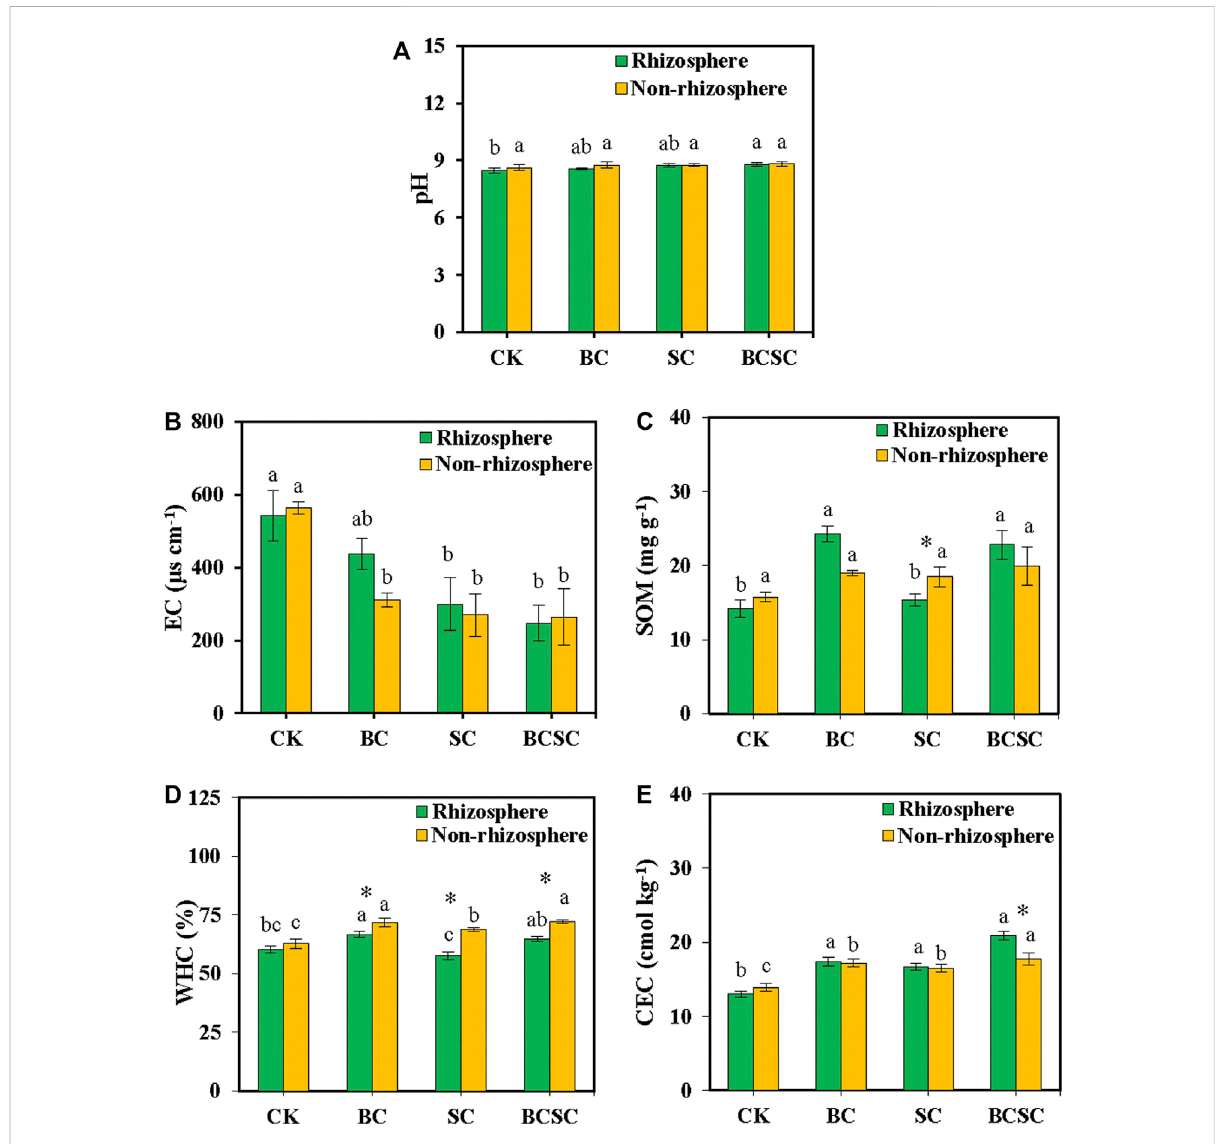
FIGURE 3 Effect of biochar, compost, and biochar-compost addition on soil properties. (A) pH, (B) EC, (C) SOM, (D) WHC, and (E) CEC. CK: soil without amendment; BC: soil amended with corn straw biochar at 1.0% (w/w); SC: soil amended with seaweed compost at 1.0% (w/w); and BCSC: soil amended with cocomposted biochar and seaweed at 1.0% (w/w). The error bars represent the standard error of the mean ( n = 3). Different small letters indicate the signi fi cant difference between the soil treatments, and asterisks indicate the signi fi cant difference between the rhizosphere and non-rhizosphere soils ( p <